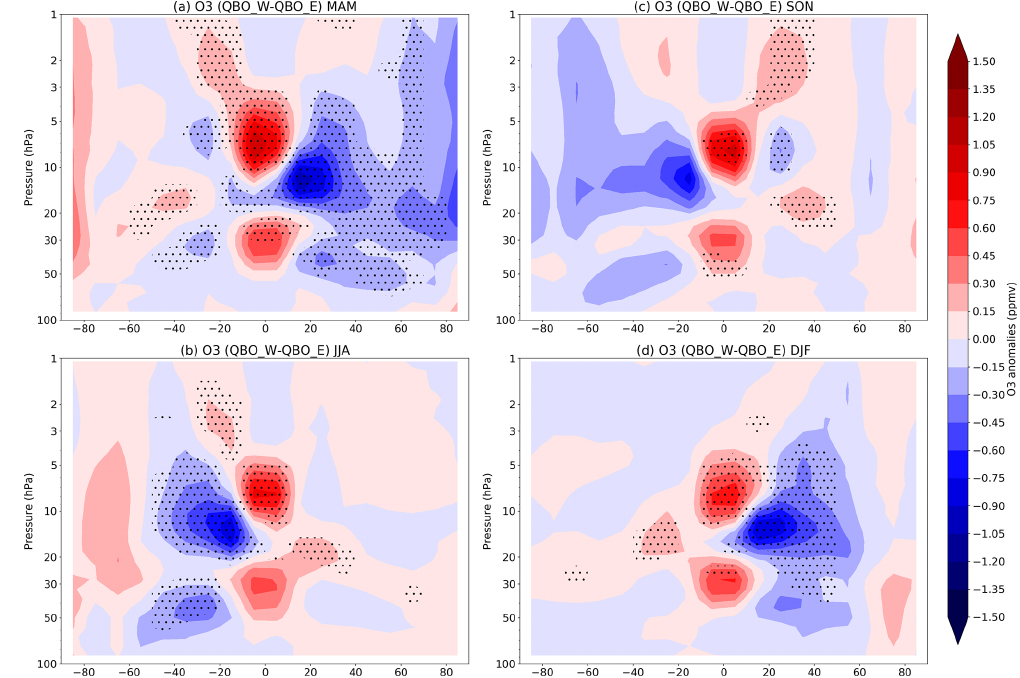
Figure 5. Latitude–height cross section of ozone anomalies associated with QBO (QBOW–QBOE) based on merged satellite data from C3S for the period 1985–2020. (a) MAM. (b) JJA. (c) SON. (d) DJF. Stippled areas indicate results that are statistically significant over the 95% level, using the two-tailed Student’s t